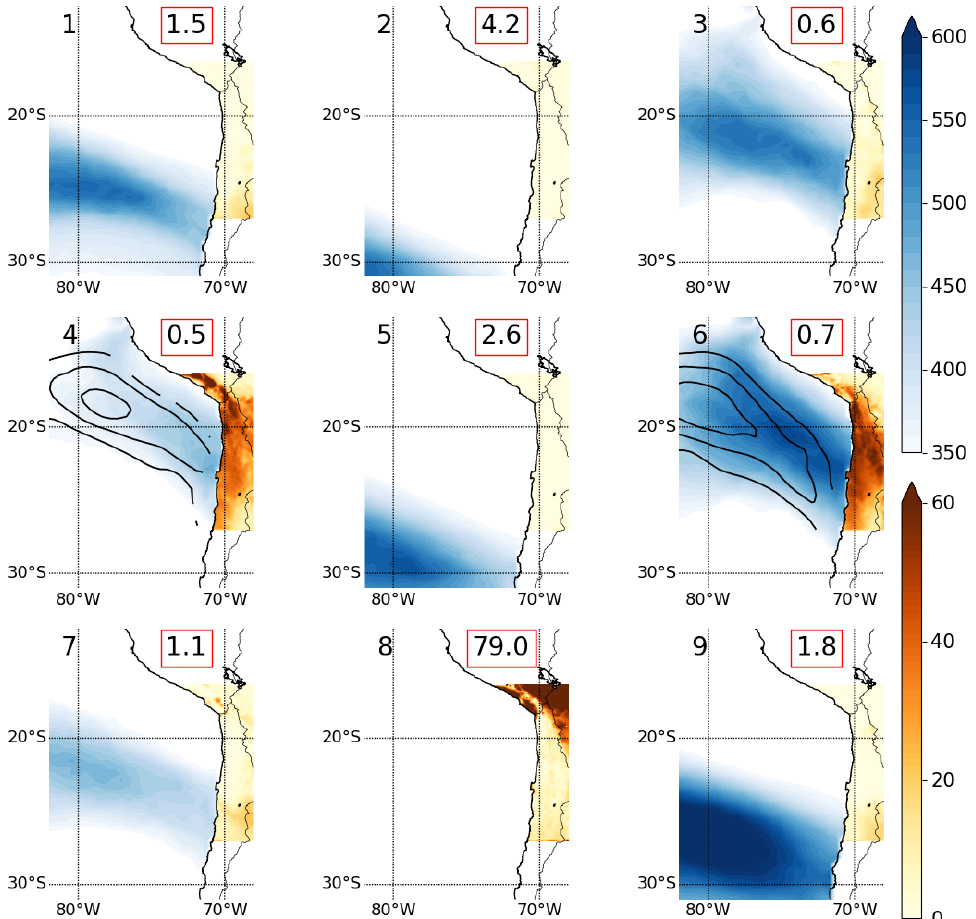
Figure 8. Final mid-Pliocene wintertime IWVF clusters (yellow–green shading, in kgm − 1 s − 1 ) as obtained by the combined SOM and k -means clustering for WRF mP (outer model domain with 50km resolution). The numbers in the red boxes are the frequencies of occurrence of the individual cluster (in days per Southern Hemisphere winter). Red–blue shading shows the fraction (in %) of the rainfall associated with the individual clusters to the total winter rainfall (inner model domain with 10km resolution). The black contours in cluster 4 and 6 show the composite mean wind speeds at 4000ma.s.l. (15, 17 and 19ms − 1 ). Note that we show IWVF exceeding 350kgm − 1 s − 1 in accordance with the definition of MCBs for the mid-Pliocene (see “Data and